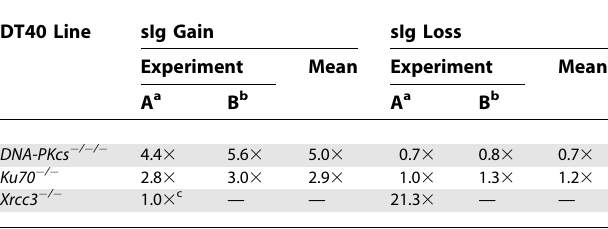
a Calculated from data in Figure 1A. b Calculated from data in Figure